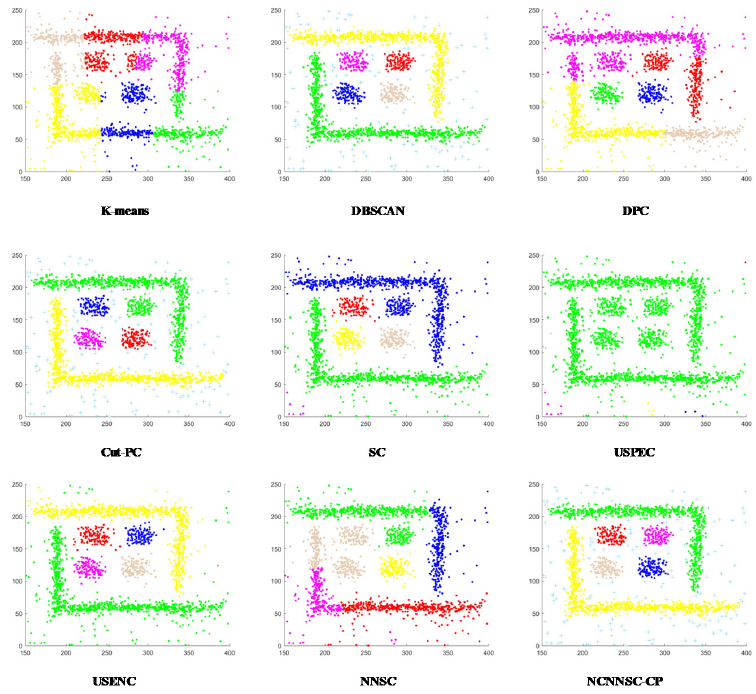
Figure 12. The results of 9 clustering algorithms in D7.